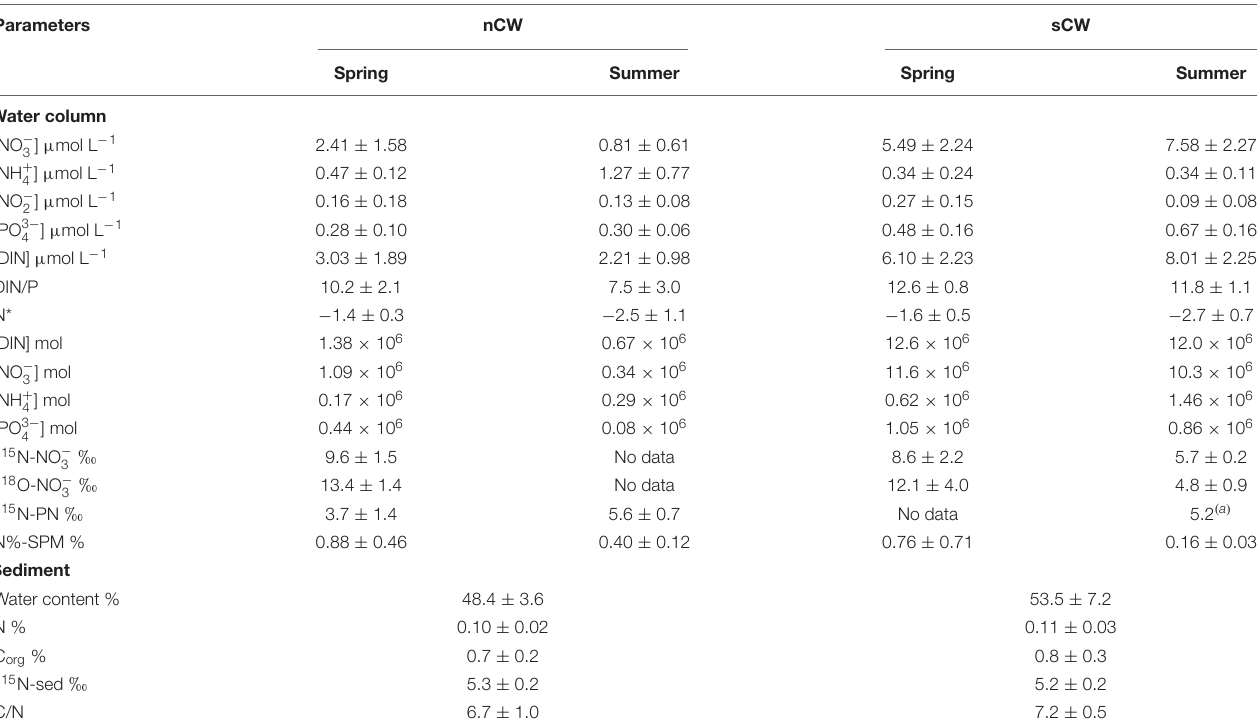
FIGURE 5 | Box and whisker plots of DIN variations in different water masses in the central Yellow Sea bottom water. [NO − 3 ] and [NH + 4 ] are marked by horizontal and vertical stripes, respectively. DINs concentrations of spring and summer are in orange and blue, respectively. The crosses and numbers represent the average values of each compound, averages of nitrite were not marked due to space restriction. The lines in the boxes are the medians, the upper and lower boxes denote the corresponding quartiles, whiskers denote the maxima and minima. TABLE 1 | Important parameters in central bottom waters in the Yellow